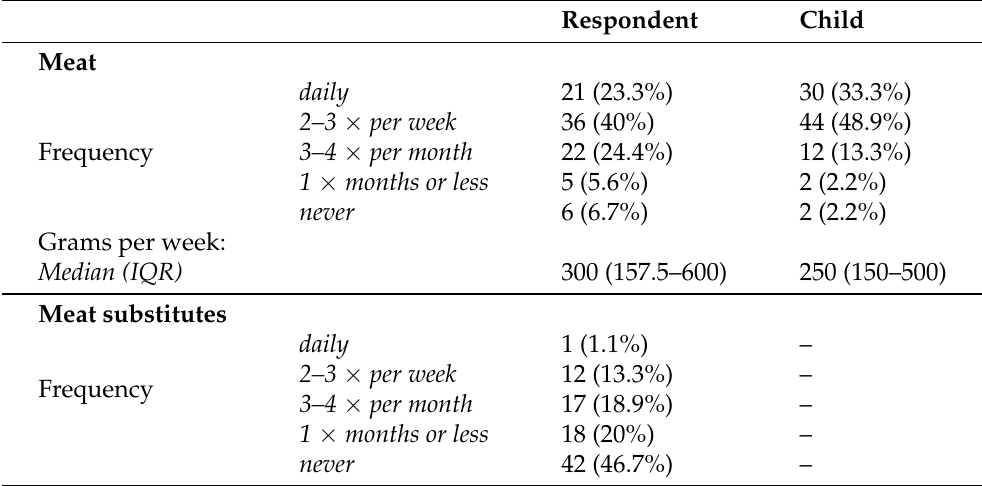
Table 2. Frequency of meat and meat substitutes consumption, as well as average grams per week of meat consumption of the respondent and